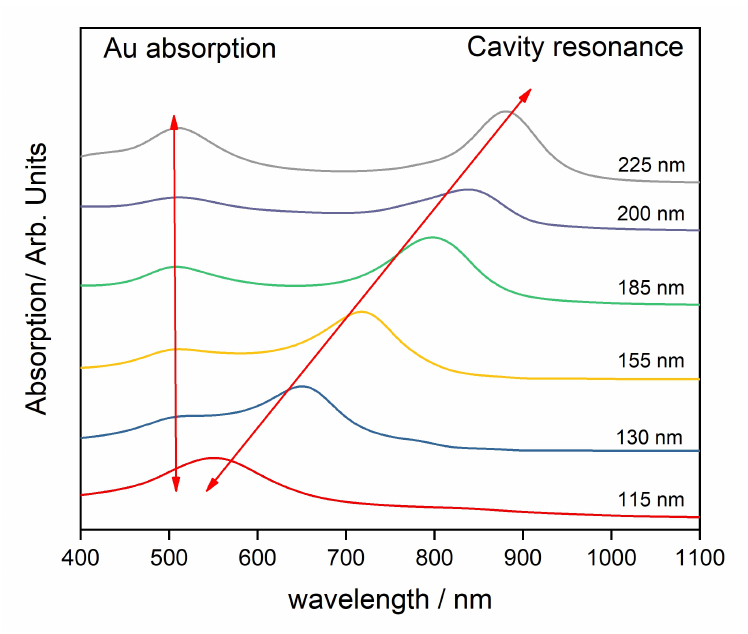
Figure 3. Absorption spectrum of PS in gold